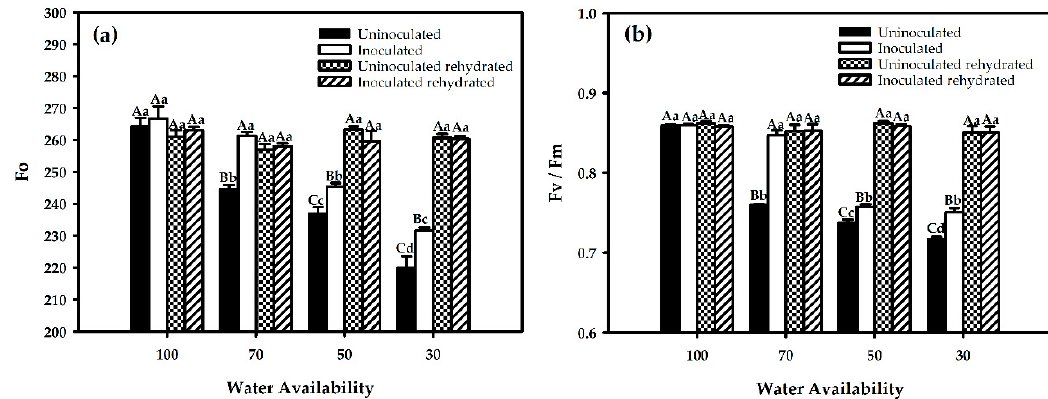
Figure 3. Initial fluorescence ( a ) and FSII maximum quantum yield ( b ) in red rice under different water restriction and inoculation conditions. Averages followed by identical capital letters do not differ in the inoculation condition for each soil water treatment, and averages followed by identical lowercase letters do not differ in the percentage of soil water. Bars represent the standard error (n = 3).